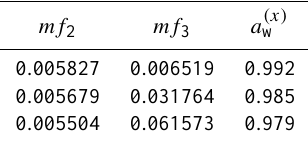
Table A9. Bulk water activity measurements of the system